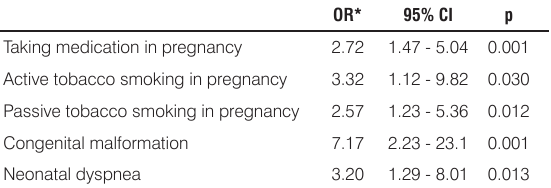
Table 4. Multivariable model of relative risk of autism (conditional logistic